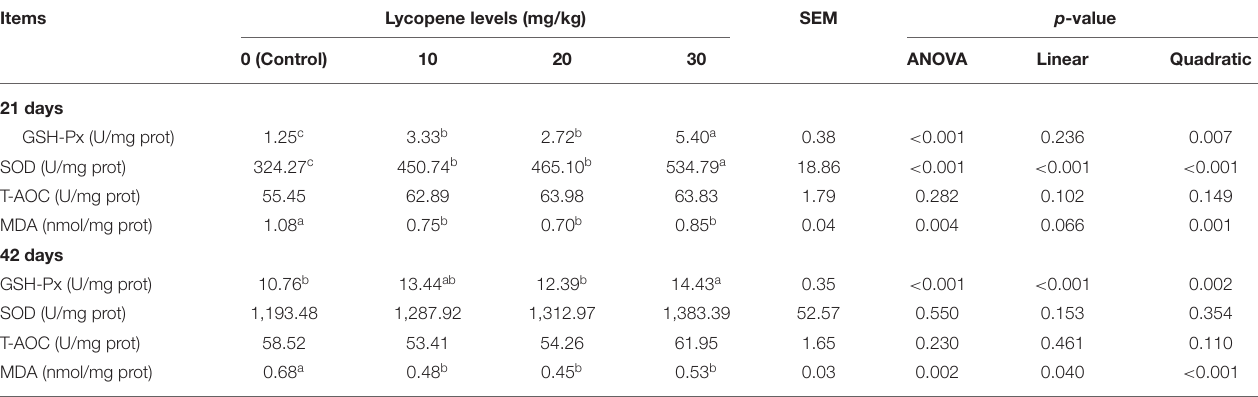
TABLE 6 | Effect of dietary lycopene on liver antioxidase of AA broilers. Items Lycopene levels (mg/kg)